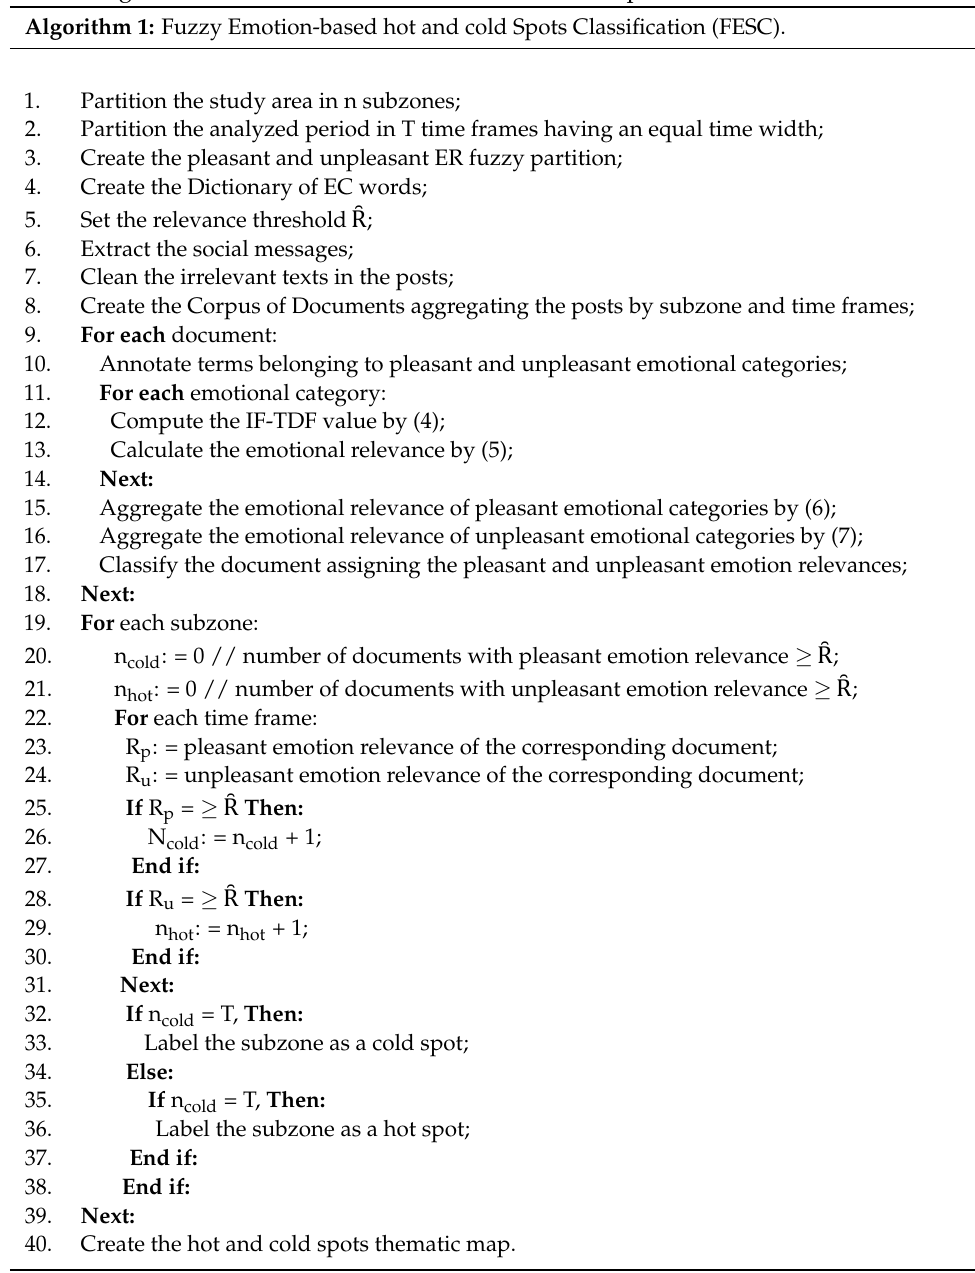
Algorithm 1: Fuzzy Emotion-based hot and cold Spots Classification